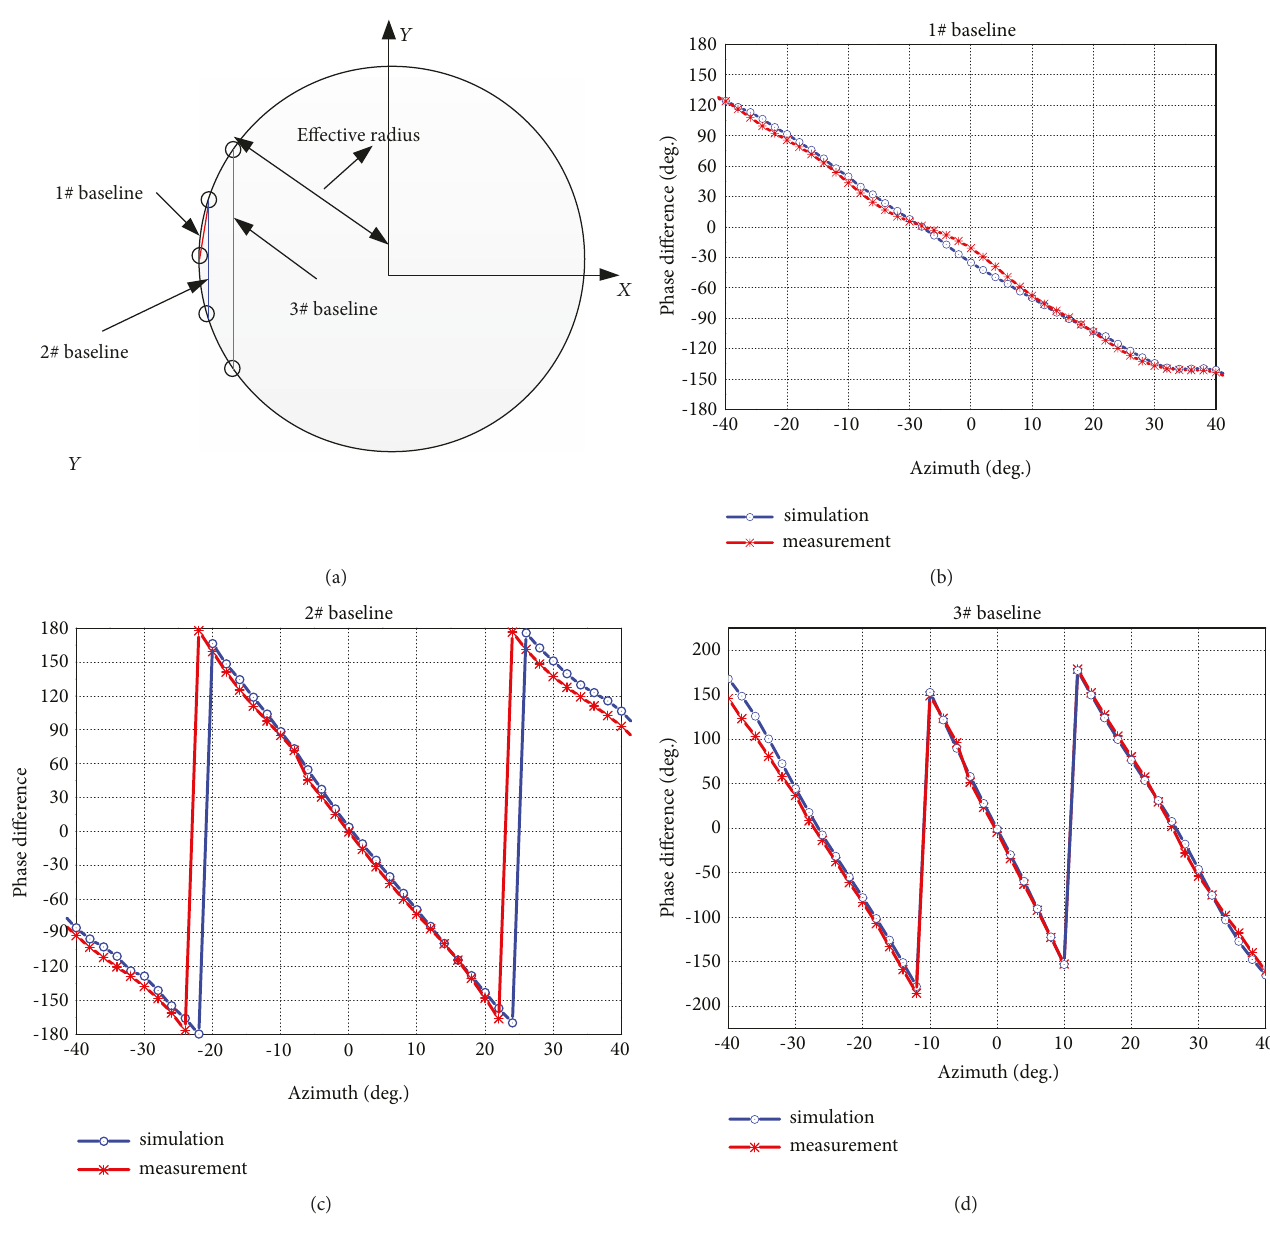
Figure 14: The phase di ff erence of the di ff erent baselines at 10 MHz: (a) the de fi nition of the baseline in the circular array and (b – d) phase di ff erence of baselines 1 ~ 3,